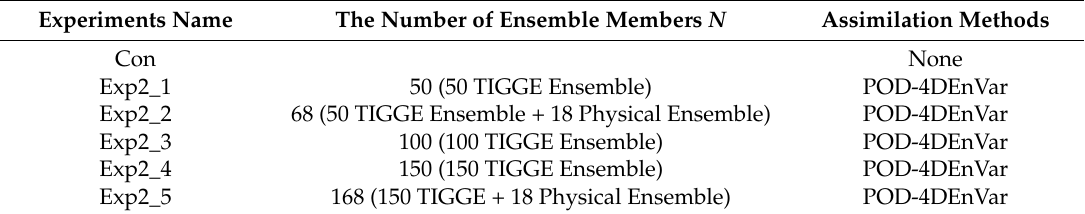
Table 6. Experimental design for ensemble size sensitivity